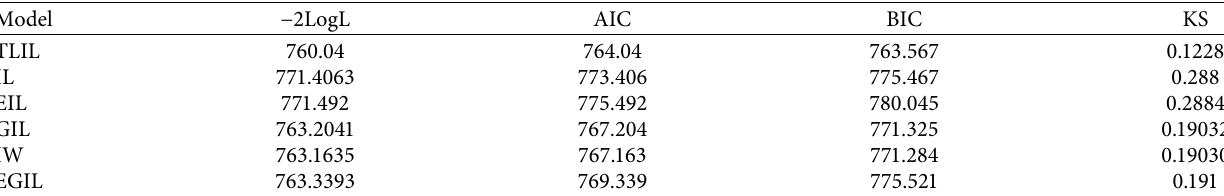
Table 8: Summary of goodness-of-fit statistics for dataset I.